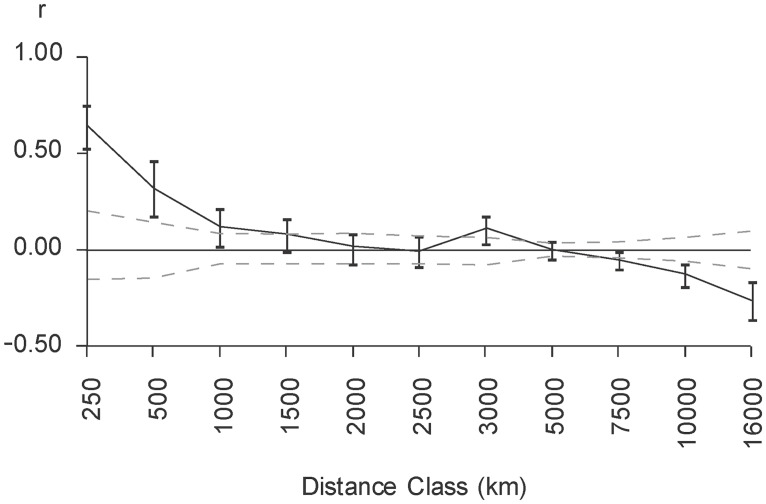
Spatial pattern of correlation of DI*A allele frequencies.Dotted lines indicate a 95% probability interval obtained with 1000 permutations for a null hypothesis of no spatial structure.